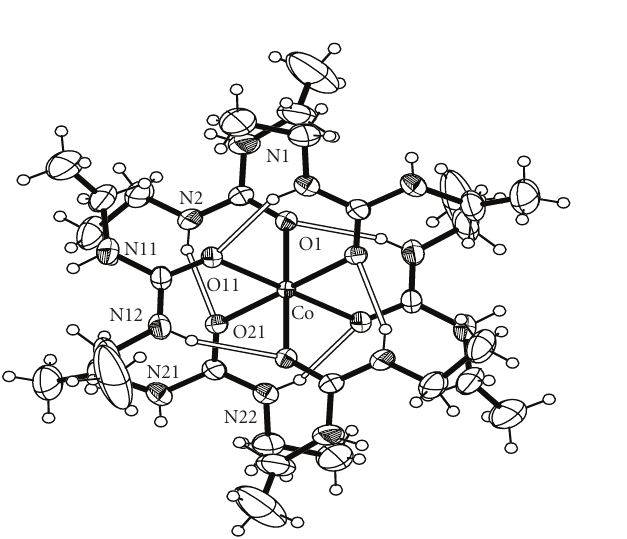
Figure 3: An ORTEP representation of the cation [Ni(DEU) 6 ] 2+ present in complex 3 . Open bonds indicate intramolecular hydro- gen bonds. The symmetry-equivalent atoms are not